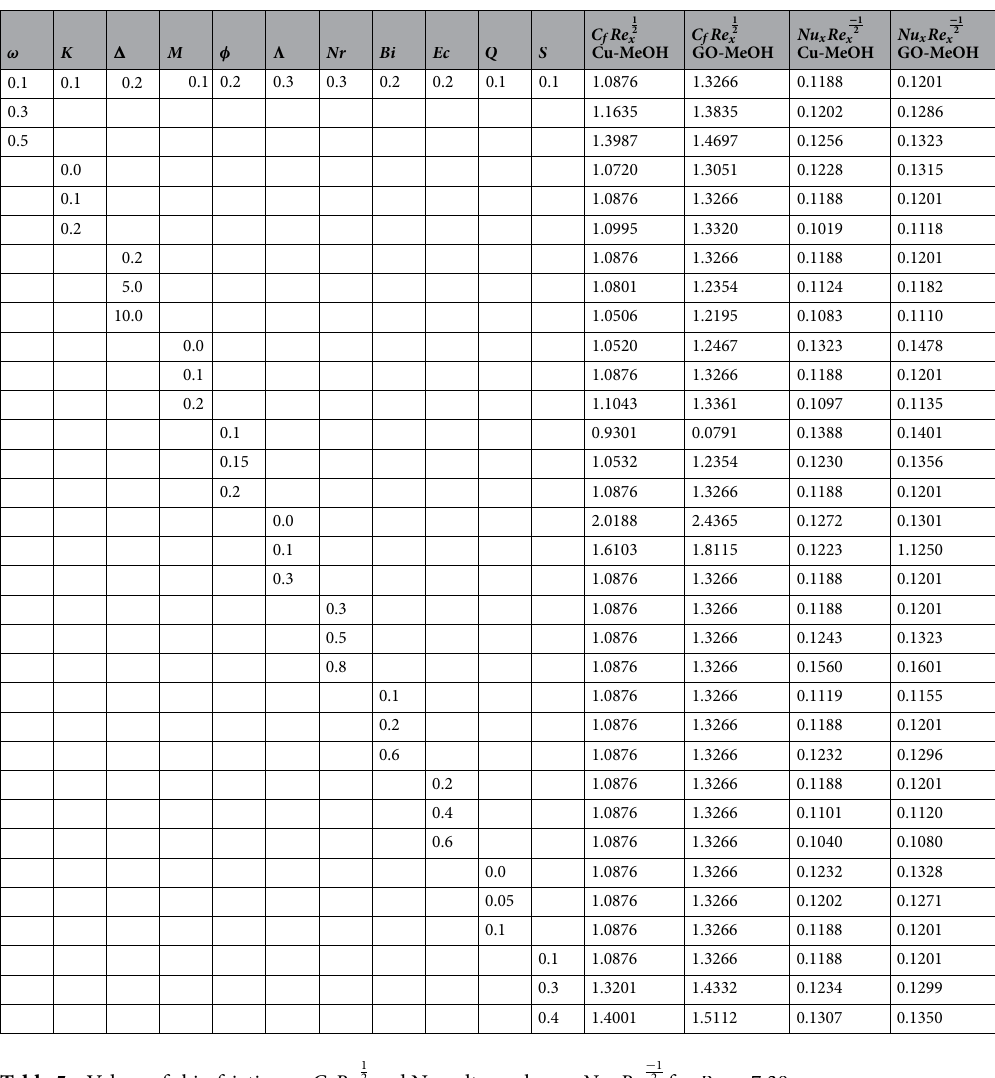
Table 5. Values of skin friction = C f Re